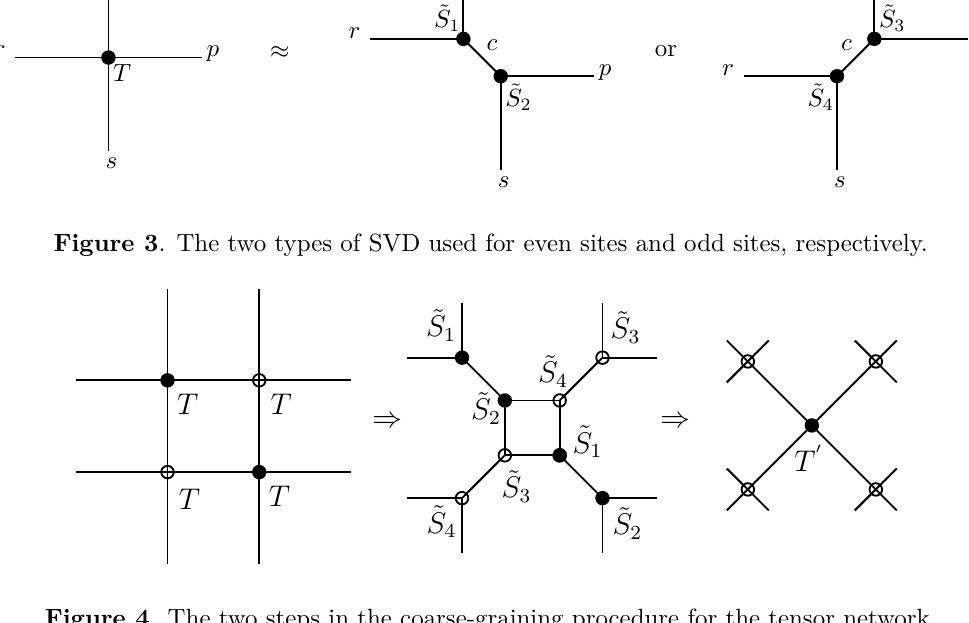
Figure 4 . The two steps in the coarse-graining procedure for the tensor